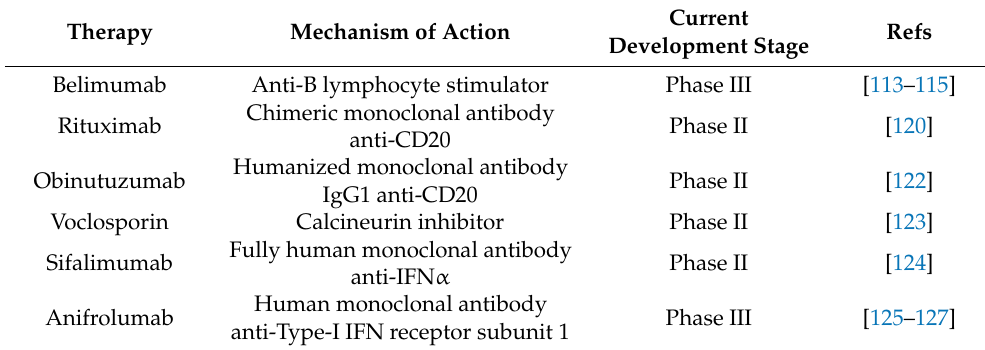
Table 1. Current biological therapy in Lupus Nephritis